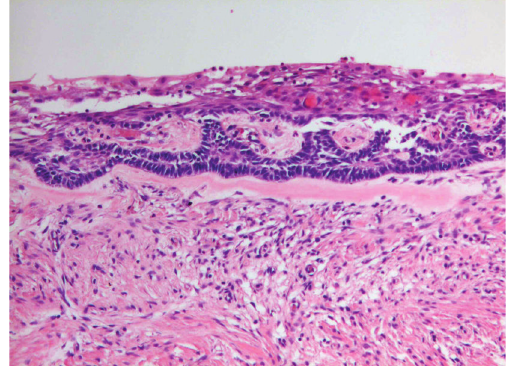
Figure 3: Adenomatoid odontogenic tumor consisting of epithelial nodules containing calcified material and interconnected with thin epithelial